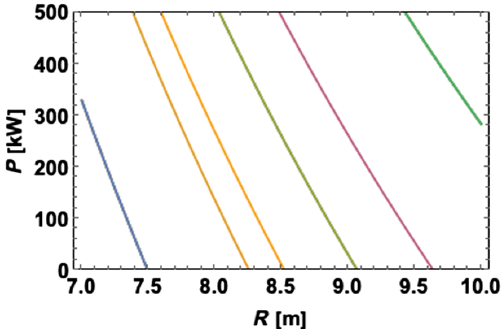
FIG. 7. The value of power at which degeneracy occurs as a function of the radius of curvature of the output coupler for mode orders from m þ n ¼ 1 to 18.